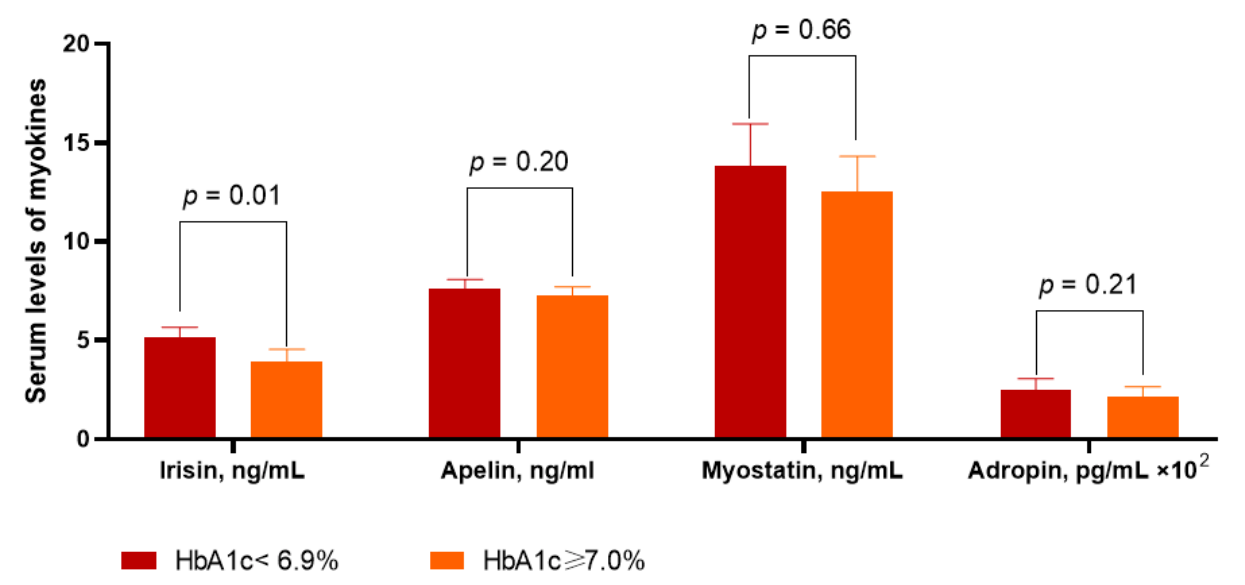
Figure 2. Myokine levels in T2DM patients with HF depending on glucose control. Abbreviations: HbA1c, glycosylated hemoglobin.